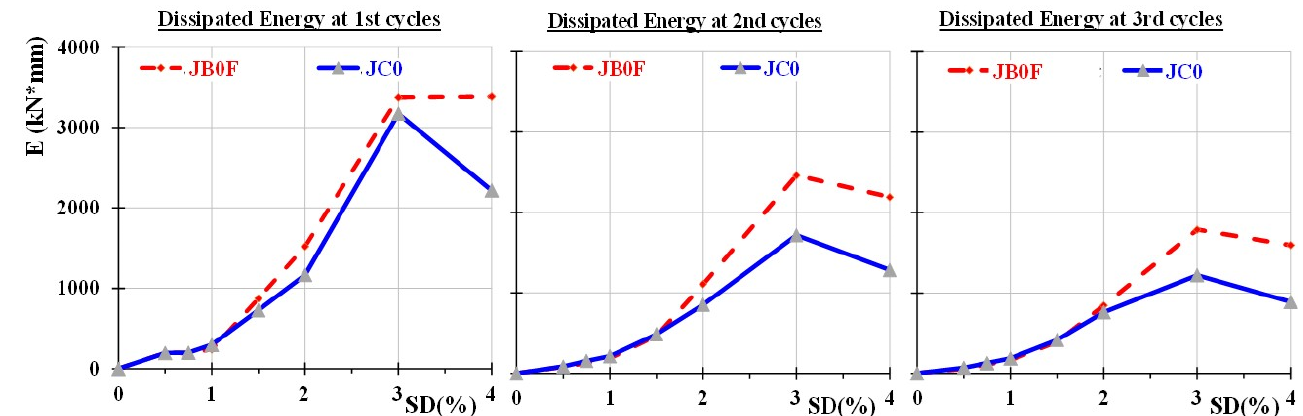
Figure 8. Comparative presentation of the dissipated energy of the two specimens in terms of the area of the hysteretic cycles. It was observed that the dissipated energy values of the strengthened specimen JB0F with the C-FRP ropes were, in all cycles, higher than the corresponding ones of specimen JC0 without C-FRP ropes.